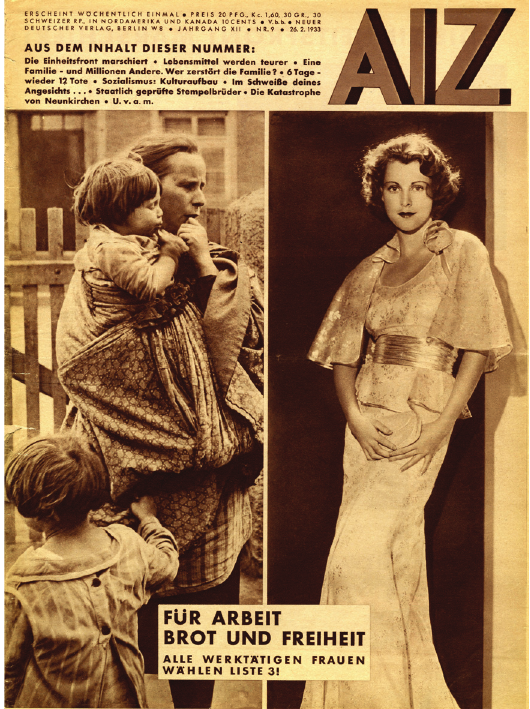
Figure 14. Cover of the Arbeiter Illustrierte Zeitung [Workers’ Illustrated Paper] addressed to female voters, February 1933. Image courtesy of Institut für Zeitungsforschung,